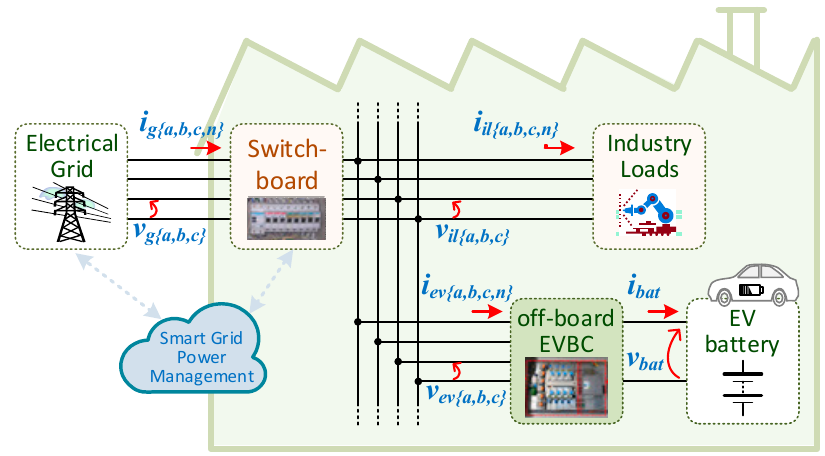
Figure 13. Illustration of the integration of an off-board EVBC into an industry.